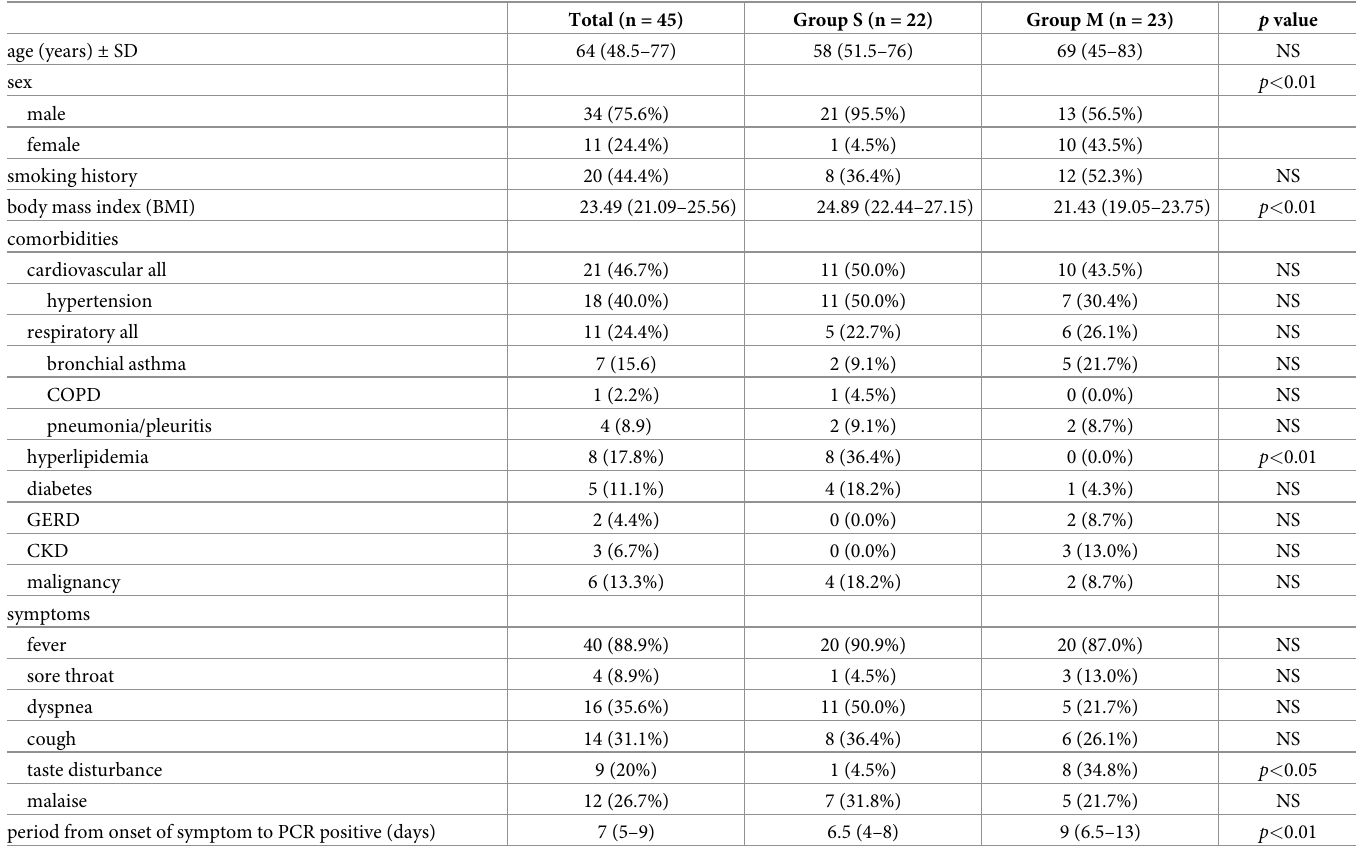
Table 1. Characteristics of the patients with COVID-19